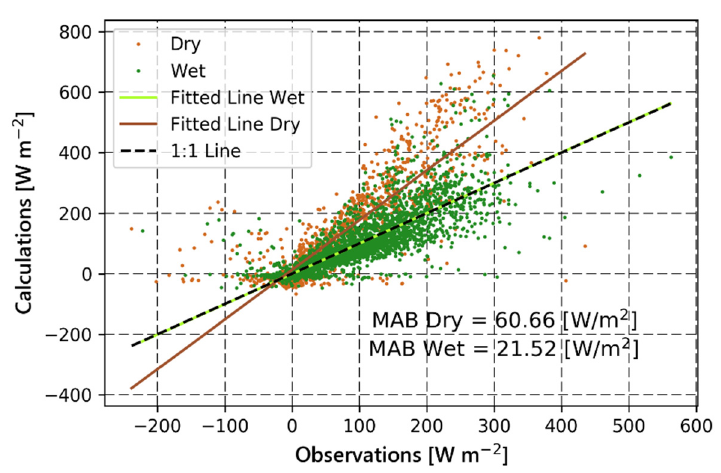
Figure 7. Latent Heat Flux estimated via the Penman-Monteith equation compared to observations. Brown points correspond to dry conditions and green points to wet conditions.